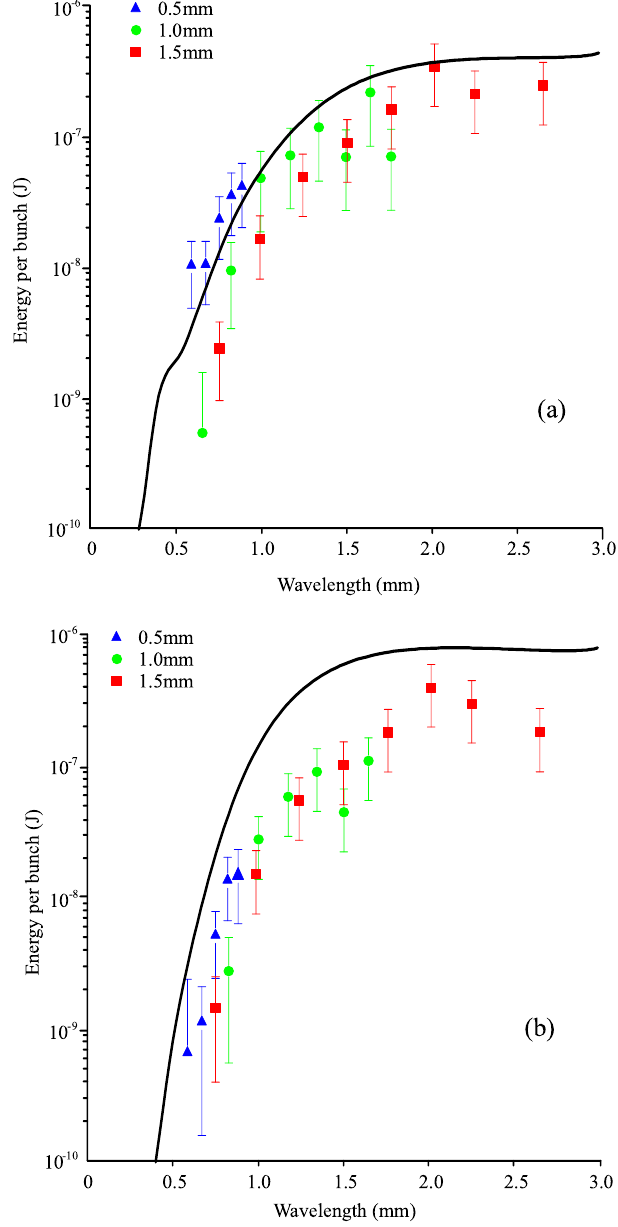
FIG. 6. (Color) Spectral distribution of coherent SP radiation measured with three gratings on: (a) the 13/07/07, between 0641–0741 and (b) the 18/07/07, between 0404–0517. The number of electrons per bunch was ffi 0 : 9 (cid:2) 10 10 and ffi 1 : 1 (cid:2) 10 10 , respectively. See text (Sec. IV C) for details of the solid